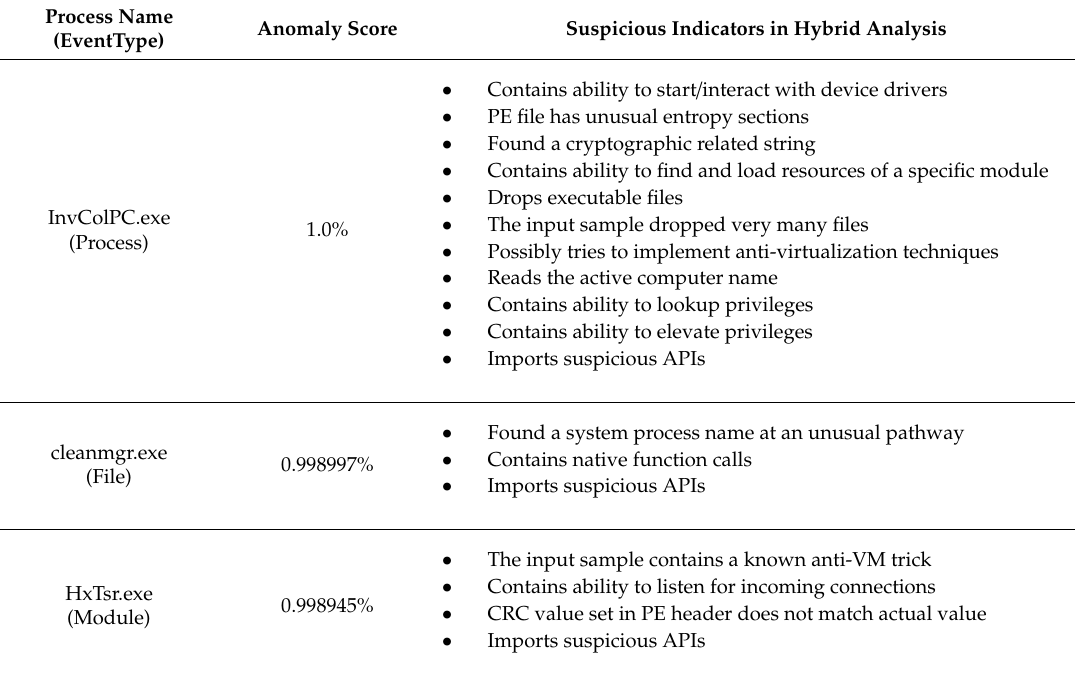
Table 6. LOF based single suspicious event analysis